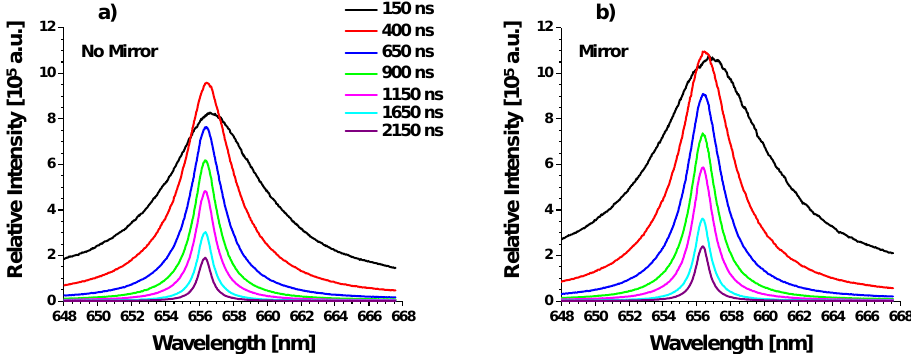
Figure 4. Temporal development of the H α line between 150 ns and 2150 ns following plasma initiation. ( a ) Measured spectra and ( b ) spectra measured with its